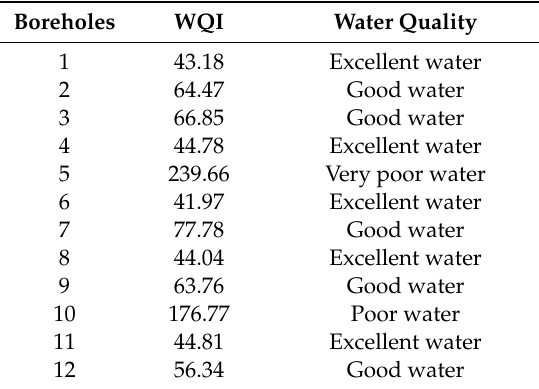
Table A1. Calculated water quality index (WQI) for each borehole water